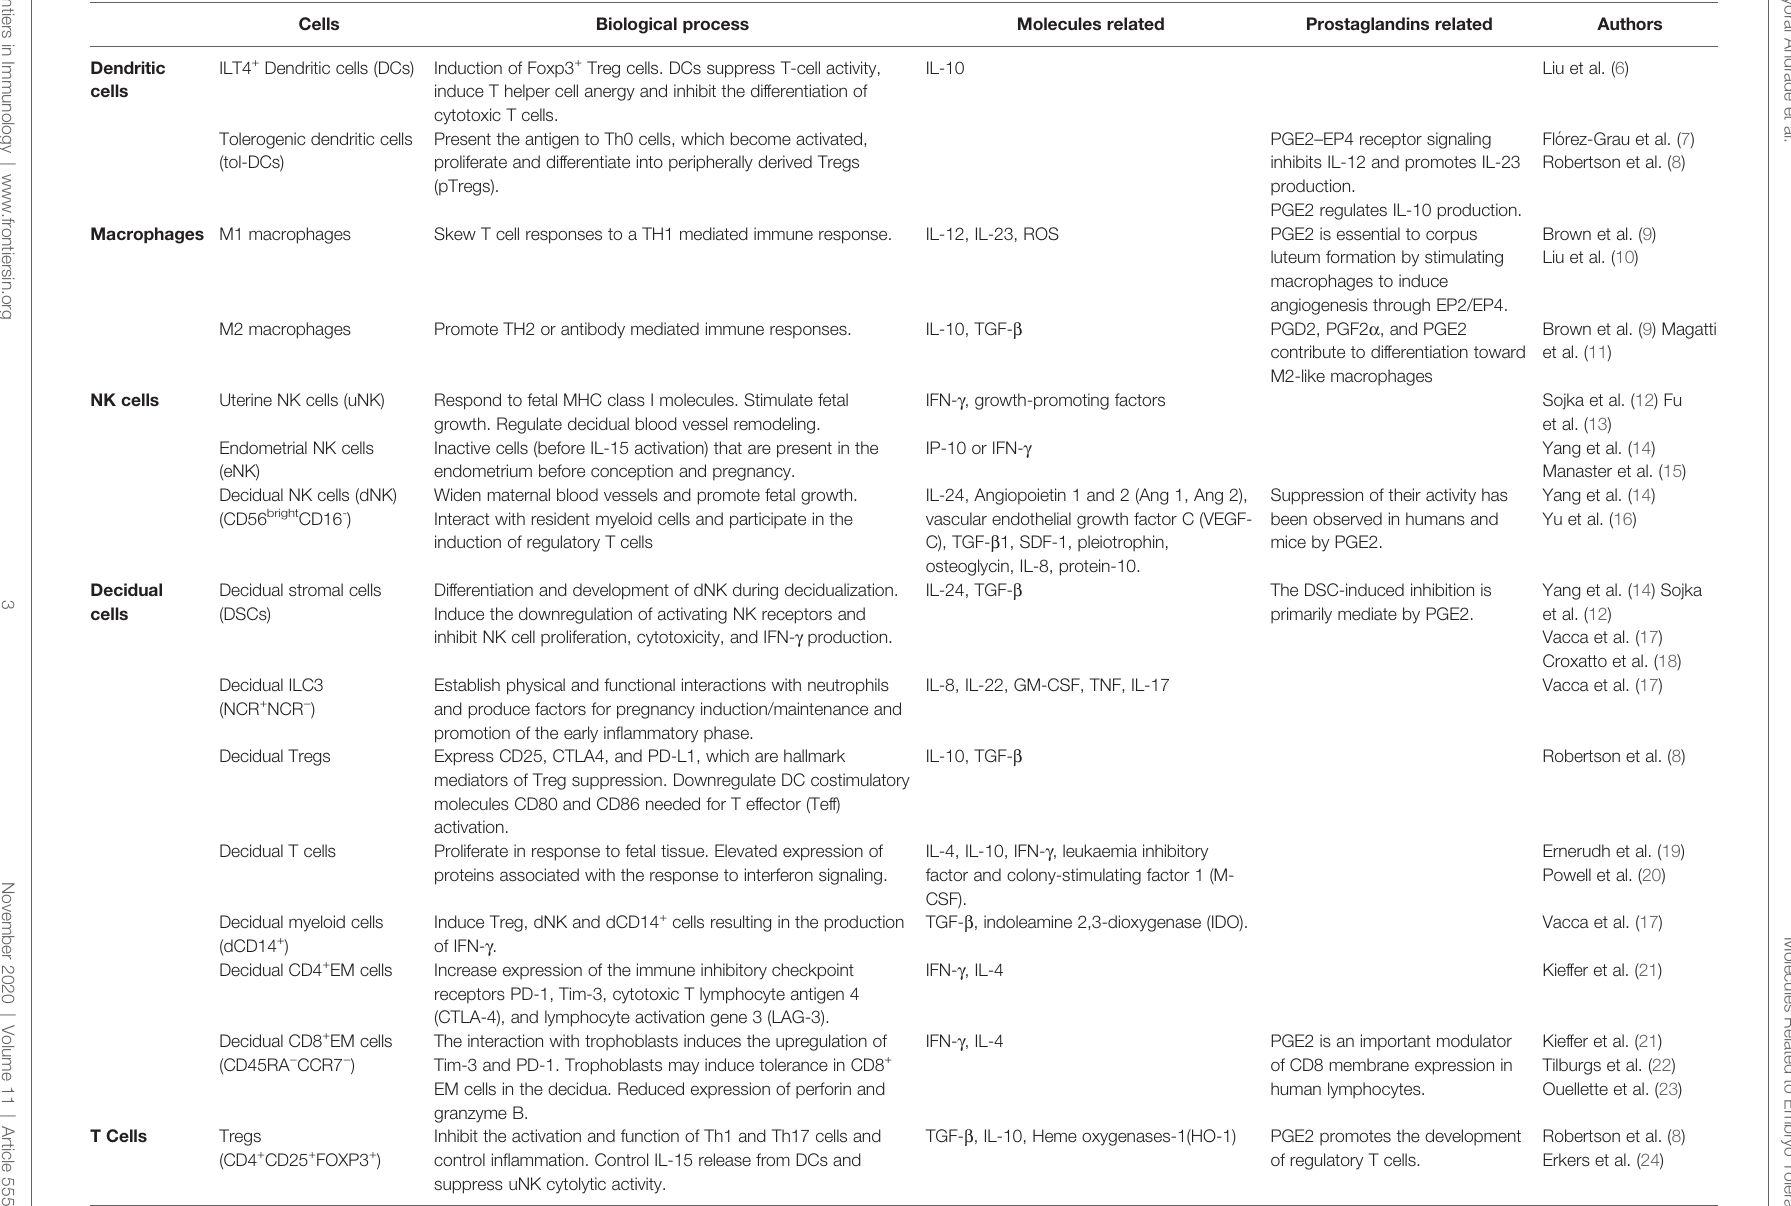
TABLE 1 | Cells related to maternal-fetal tolerance and